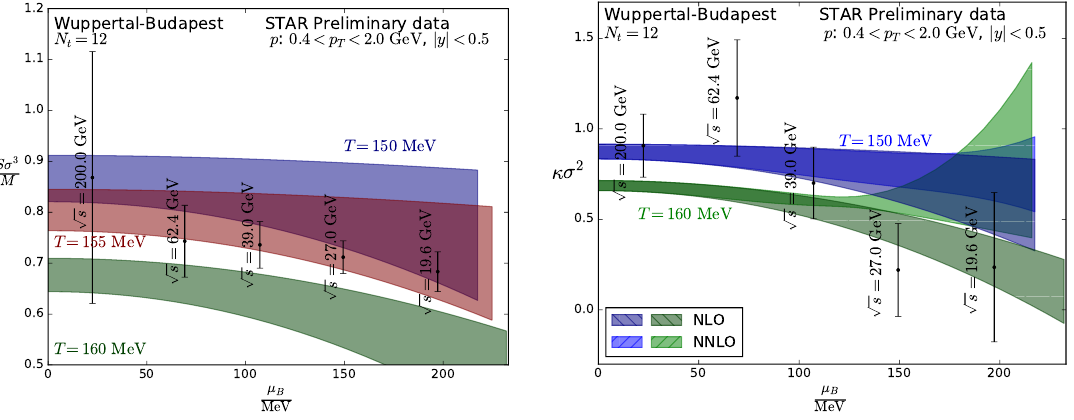
B Figure 8 . Taylor expansion coe(cid:14)cients for (cid:20) B (cid:27) 2 = (cid:31) as functions of the temperature: r B; 0 4 ( T; ^ (cid:22) B ) B (cid:31) B 2 ( T; ^ (cid:22) B ) (left panel) r B; 2 (middle panel), r B; 4 (right panel). The latter is not obtained independently, but 42 42 by means of the prior ansatz (see text): for this reason, we plot it in green.